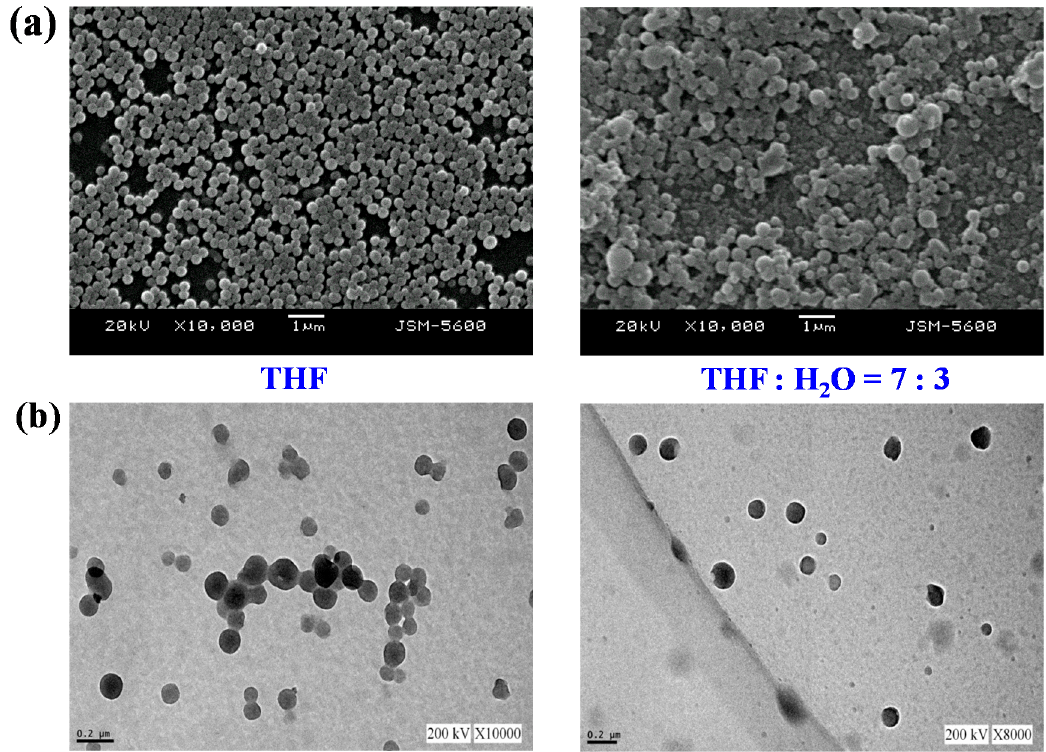
Figure 8. ( a ) SEM and ( b ) TEM images of spherical micelles formed from PCaT in different amounts of THF ‒ H 2 O. The polymer concentration was 0.5 and 0.25 mg mL − 1 for SEM and TEM observation, respectively.